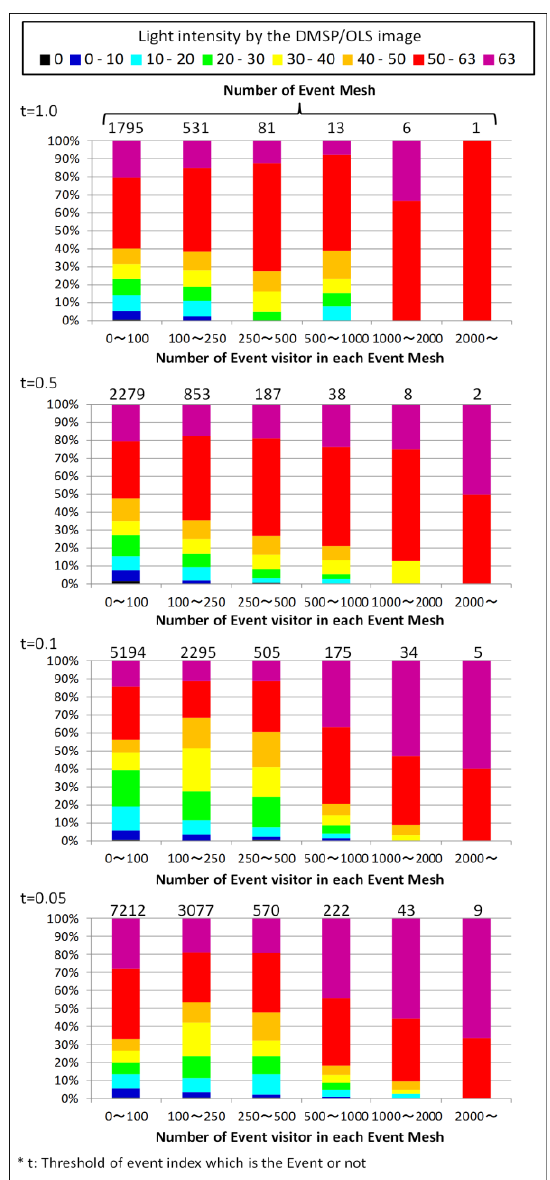
Figure 14. 100% stacked column charts for differences of the number of Event visitor in each Event Mesh and light intensity by differences of the threshold of event